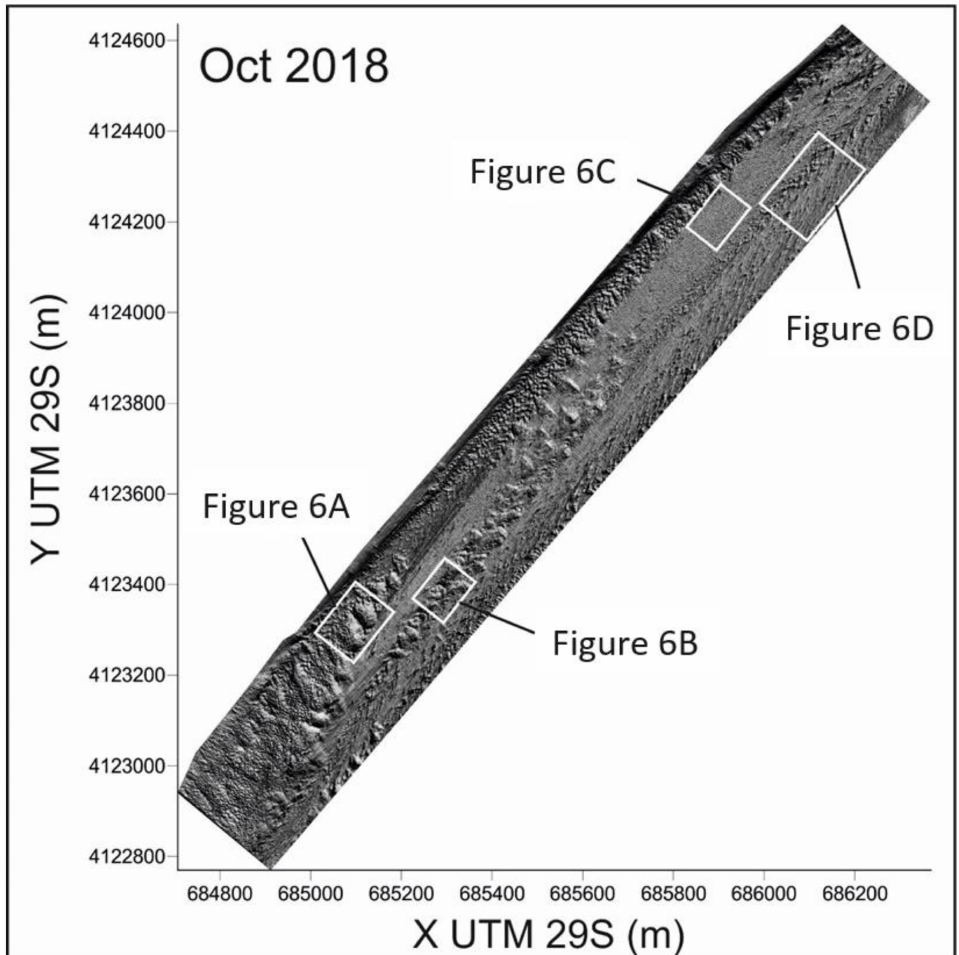
Figure 5. Shaded relief from October 2018 multibeam bathymetric data. The position of some features described in the text and included in the Figure 5 is